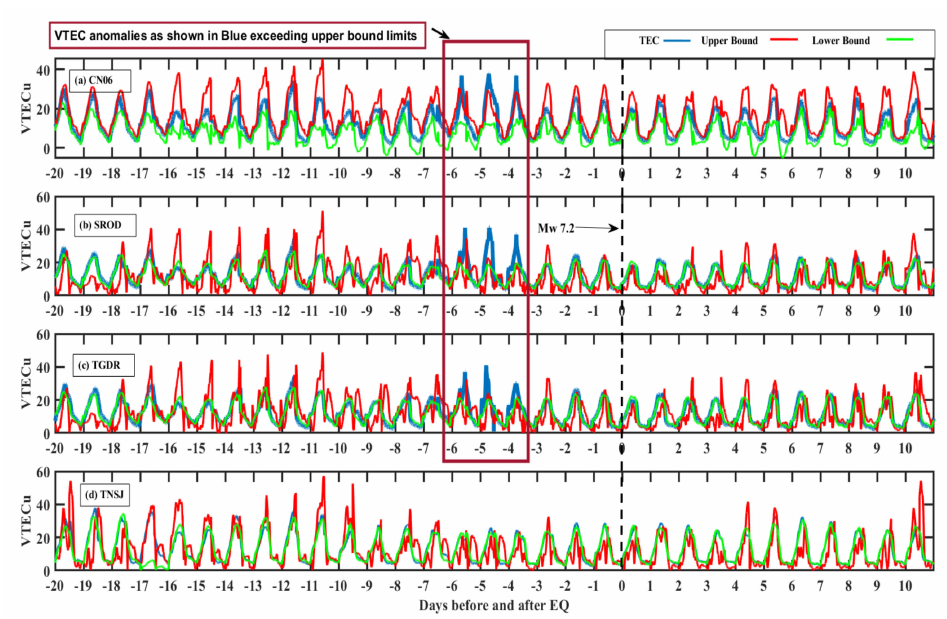
Figure 3. The measurements were recorded at four IGS stations (( a ) CN06, ( b ) SROD, ( c ) TGDR, ( d ) TNSJ) before and after the main shock day. As TNSJ station is located outside the Dobrovolsky region, it shows very minute TEC variations. The black dashed line represents the EQ day.